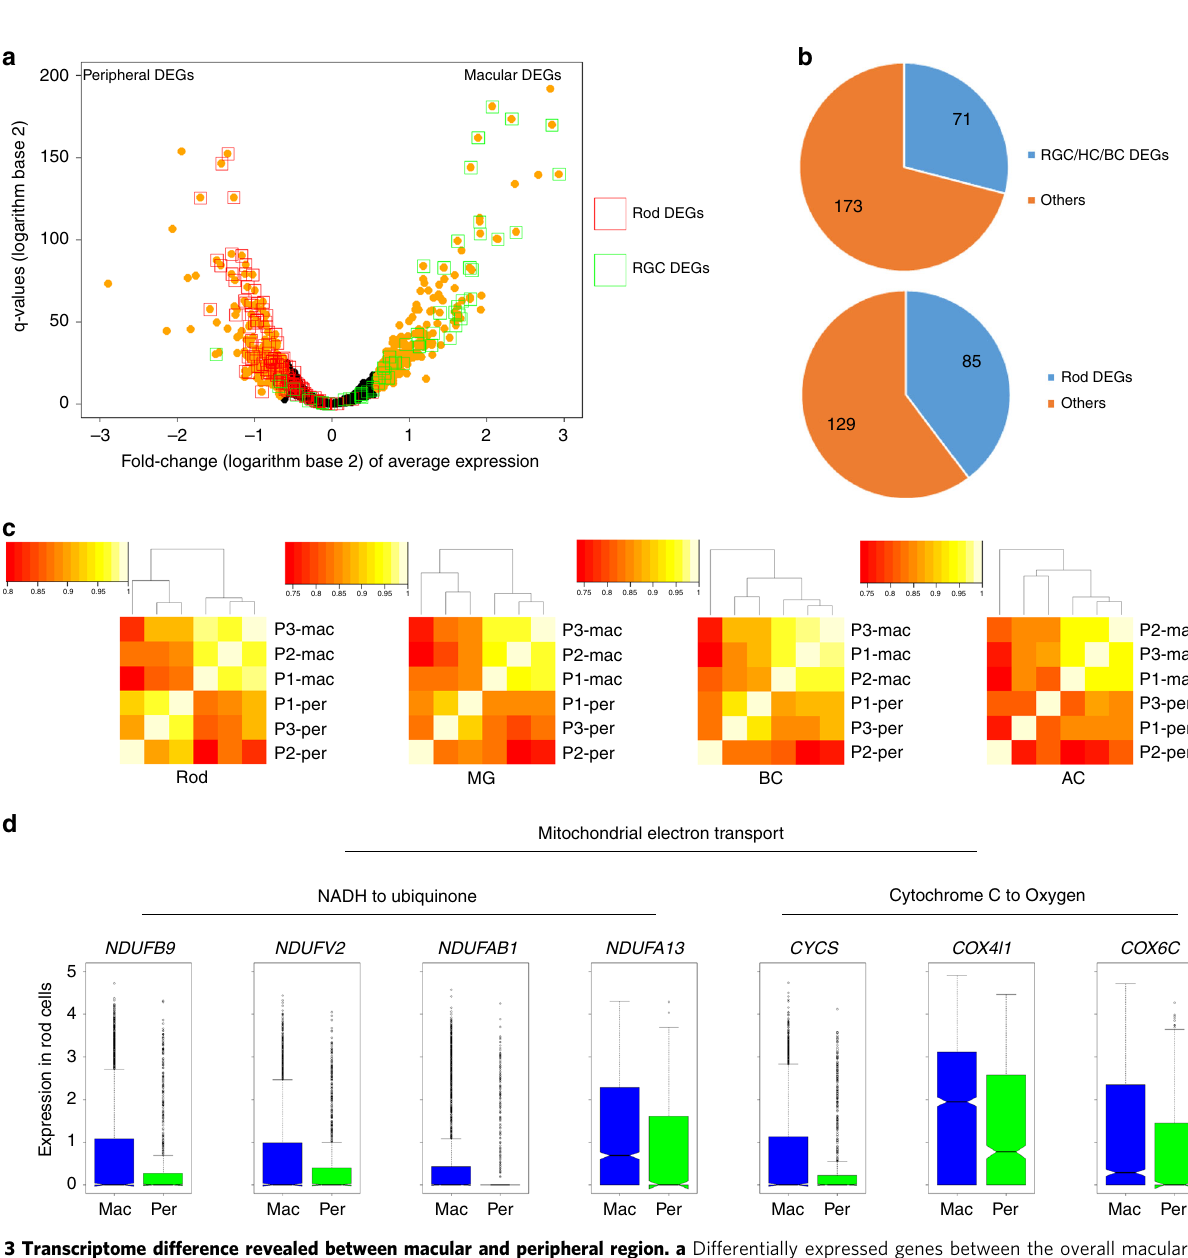
Fig. 3 Transcriptome difference revealed between macular and peripheral region. a Differentially expressed genes between the overall macular and peripheral cells. All genes detected in more than 20% of macular or peripheral cells were plotted. Macular/Peripheral DEGs by overall comparison were labeled orange. Rod DEGs and RGC DEGs were labeled as red and green boxes, respectively. b The proportion of cell-type DEGs in the overall macular- peripheral DEGs showing cell population affection on DEG detection. c Heatmap demonstrating the correlation of averaged gene expression of four major cell types (rod, MG, BC, AC) in six samples. d Demonstration of mitochondrial-electron transport-related genes showing differential expression in rod cells in the macular and peripheral region. In the box plots, bounds of the box spans from 25 to 75% percentile, center line represents median, and whiskers visualize 1.5 times inter-quartile range less than quartile 1 or 1.5 times inter-quartile range more than quartile 3 of all the data